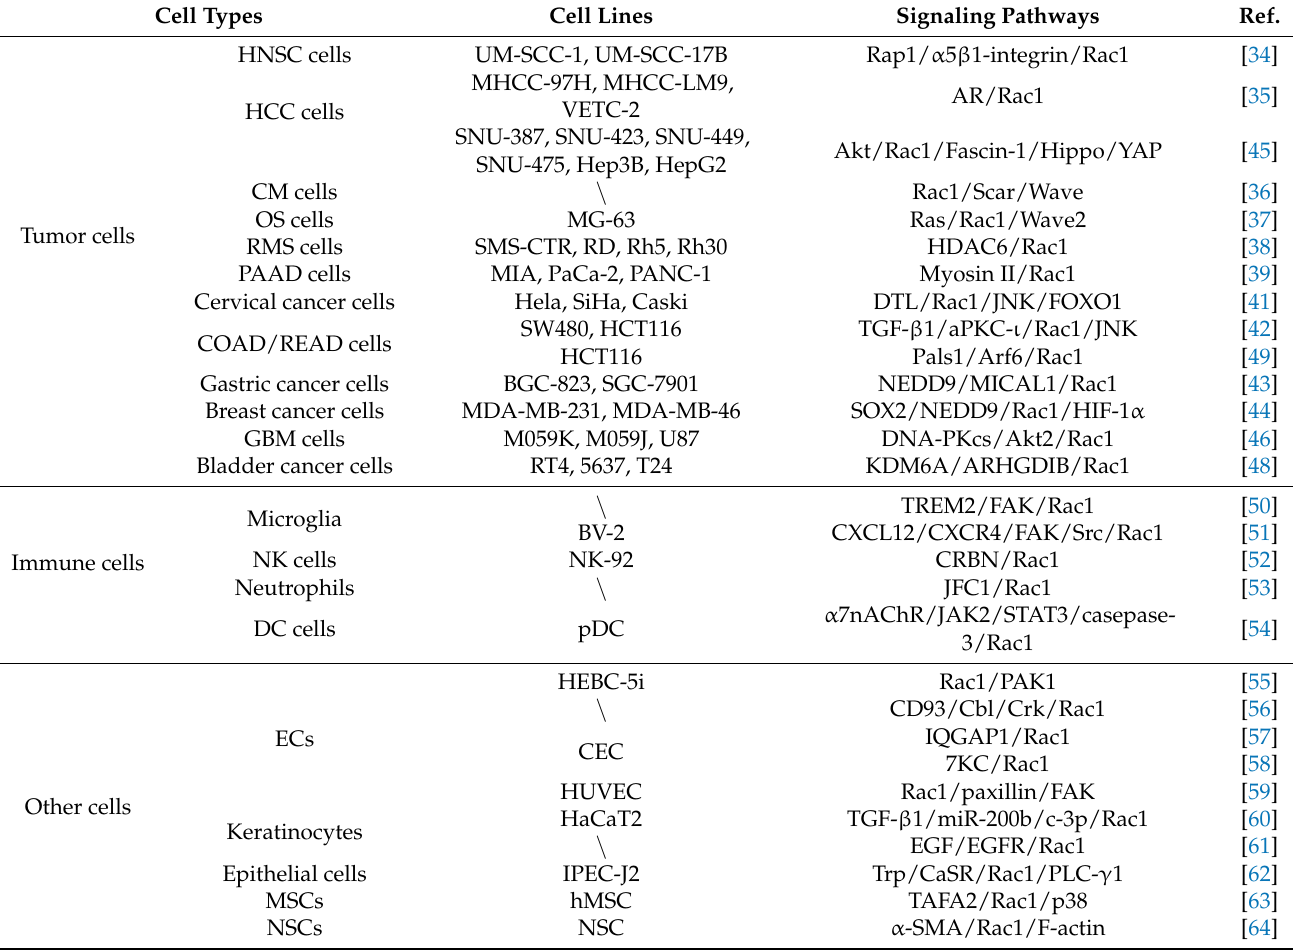
Table 1. Cell migration regulated by Rac1 and the involved direct or indirect signaling